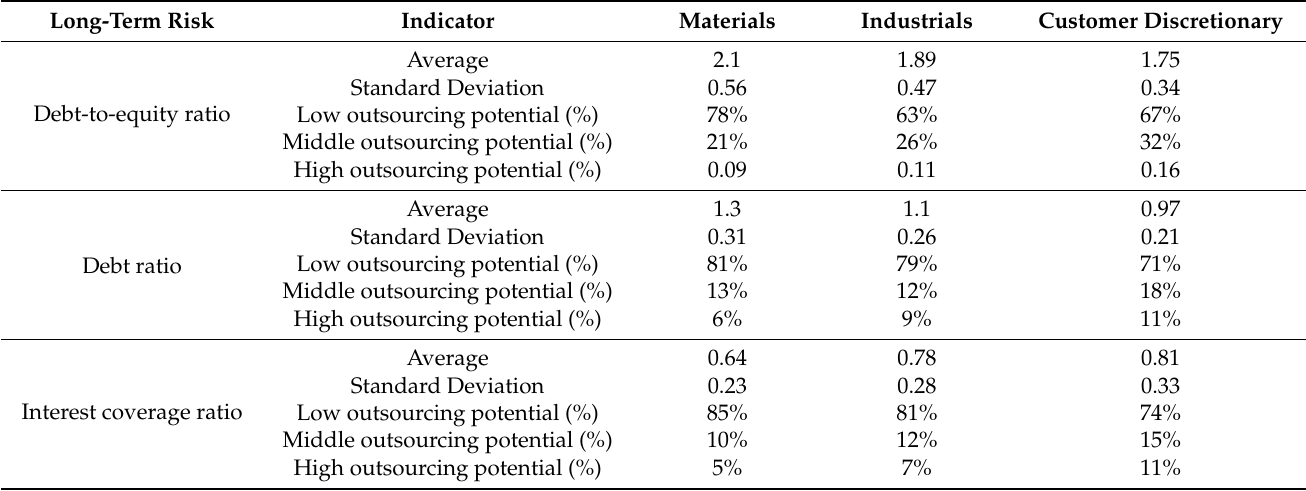
Table 7. Long-term risk results for enterprises included in the